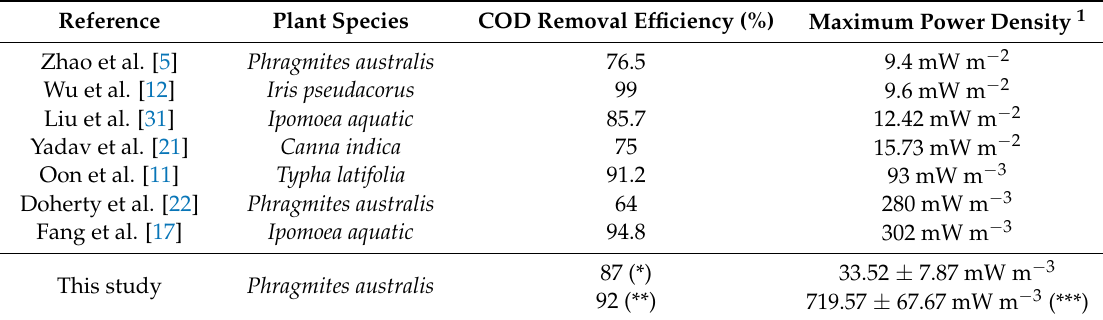
Table 2. Comparison of COD removal efficiency and power density between previous studies and this